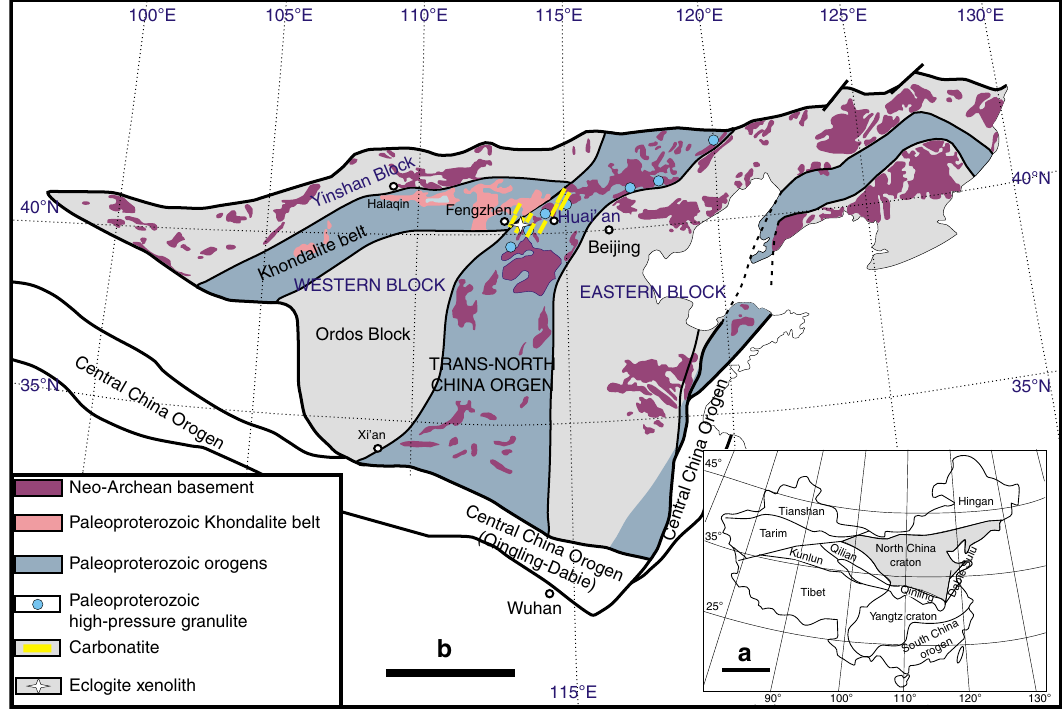
Fig. 1 Schematic geological map of the North China craton (NCC) with the location of the eclogite xenoliths. The maps are after Zhao et al. 16 . a The NCC is separated from Yangtze craton by Qinling orogen 16 . b The Eastern and Western blocks in the NCC were amalgamated by the Paleoproterozoic Trans-North China Orogen (TNCO) 16 . The Paleoproterozoic carbonatite and its associated eclogite xenoliths and high-pressure granulites 17 occur in the TNCO. The scale bar is 800 and 400 km in a and b ,